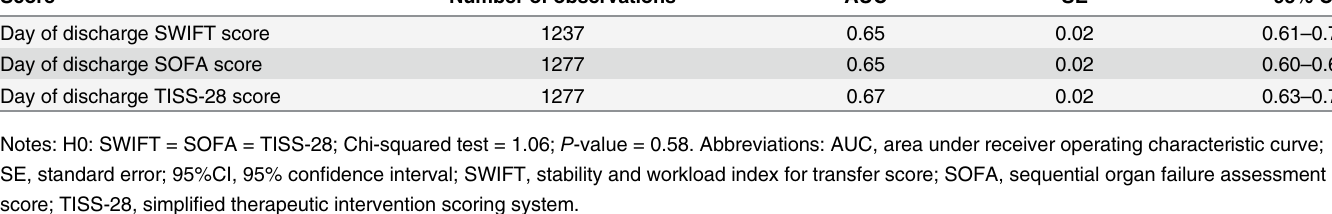
Table 7. Comparison of predictive accuracy for unplanned intensive care unit readmission or death among SWIFT, SOFA and TISS-28 scores.